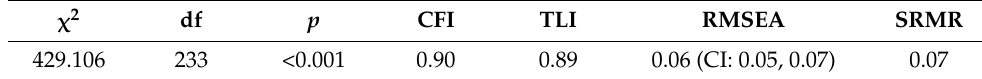
Table 3. Fit indices of the three models tested.